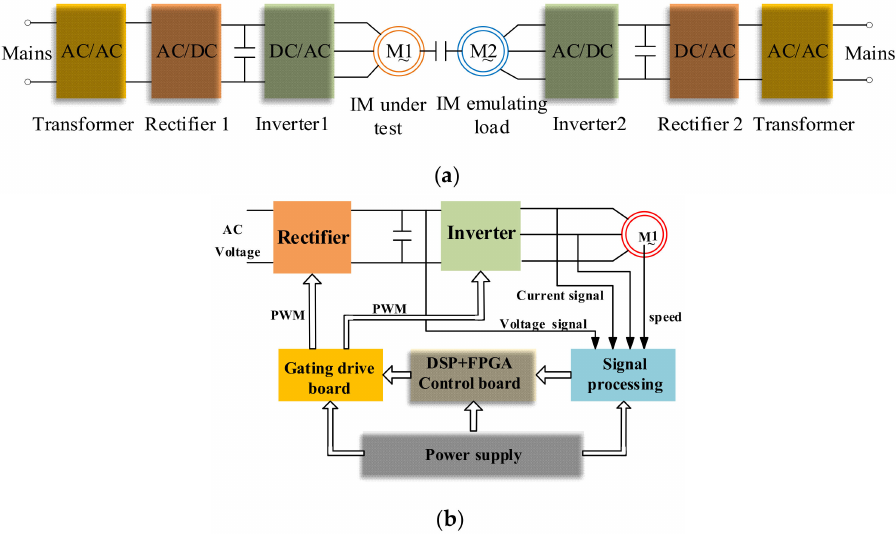
Figure 25. Experiment configuration: ( a ) Two coaxially connected inverter-motor systems; ( b ) Structure for the motor drive system in